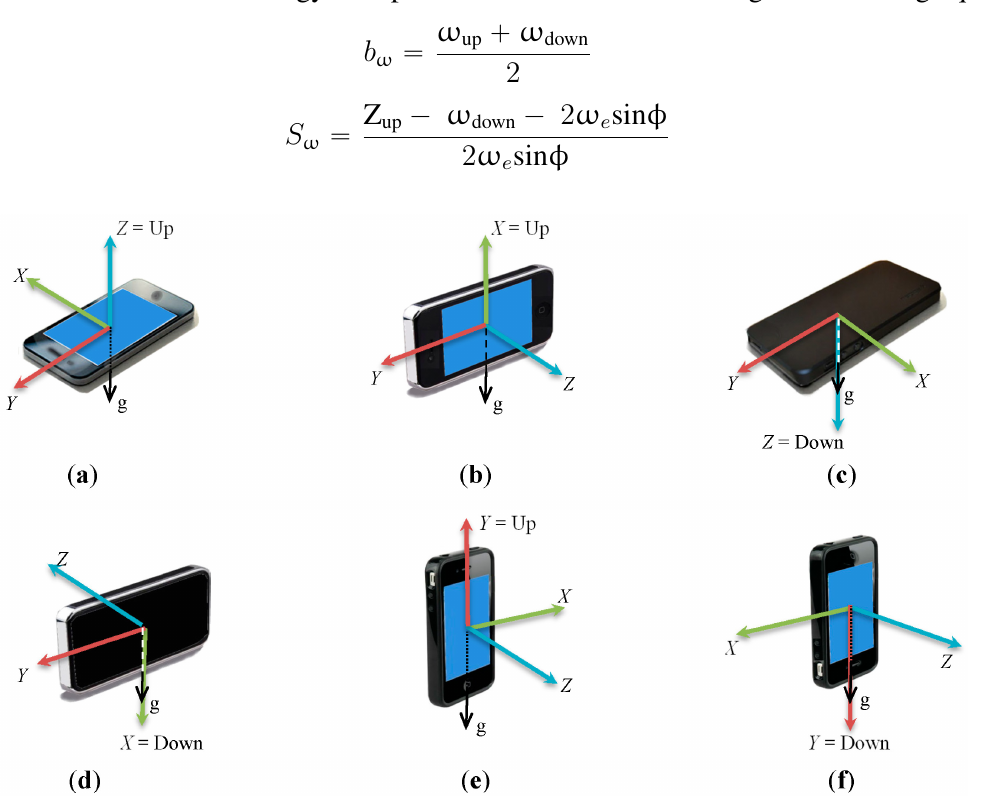
Figure 2. Six different positions for calibration of the accelerometer and gyroscope (each sensitive axis pointing alternately up and down). ( a ) Z -axis is along with g but in the opposite direction; ( b ) X -axis is along with g but in the opposite direction; ( c ) Z -axis is along with g and with the same direction; ( d ) X -axis is along with g and with the same direction; ( e ) Y -axis is along with g but in the opposite direction; ( f ) Y -axis is along with g and with the same direction.